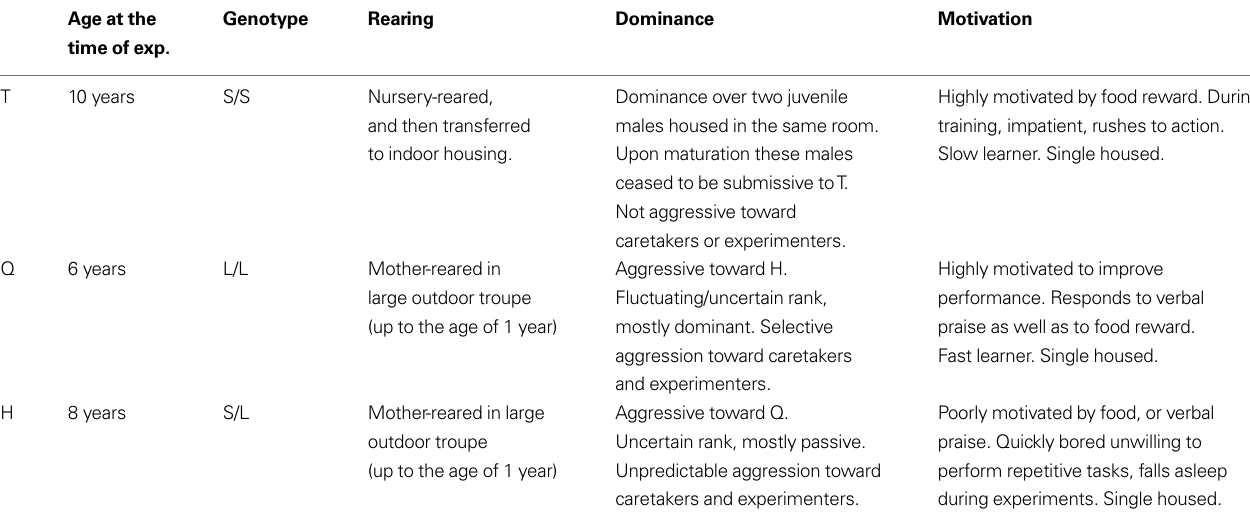
Table 1 | Compilation of known biographical, behavioral, temperamental, and genetic characteristics for the three experimental monkeys. Age at the Genotype Rearing Dominance Motivation time of exp.